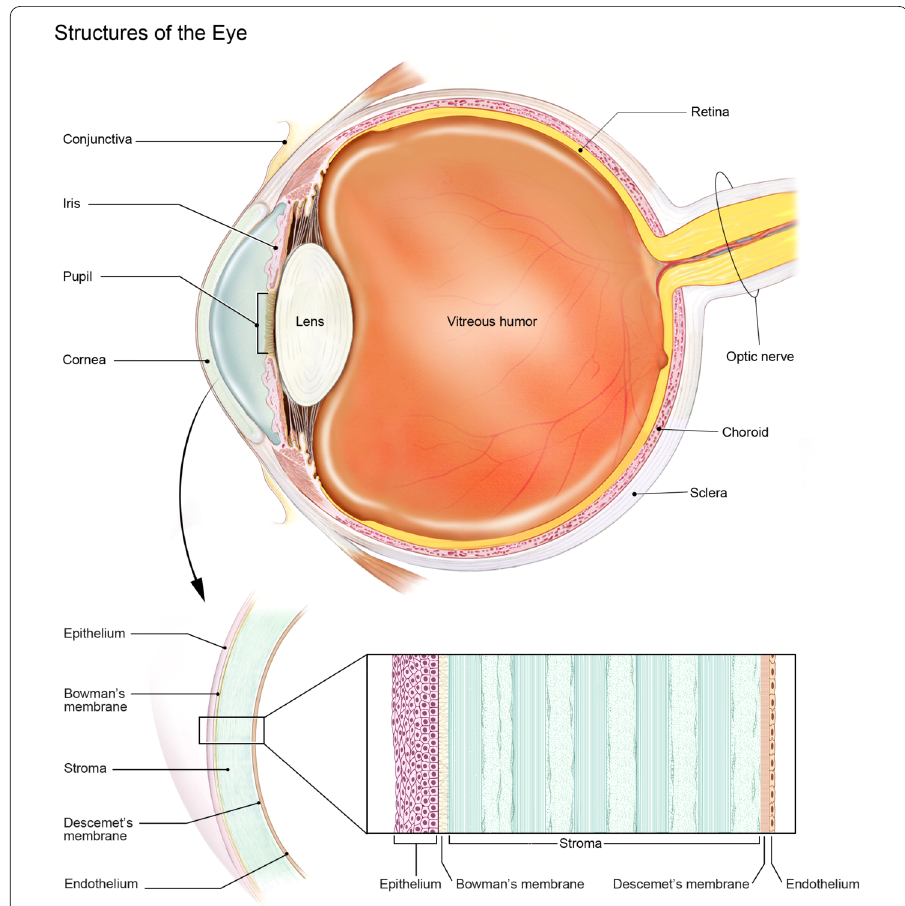
Figure 1 Anatomy of the human eye with corneal cross-section. Autor: National Eye Institute (licensed under CC BY 2.0)